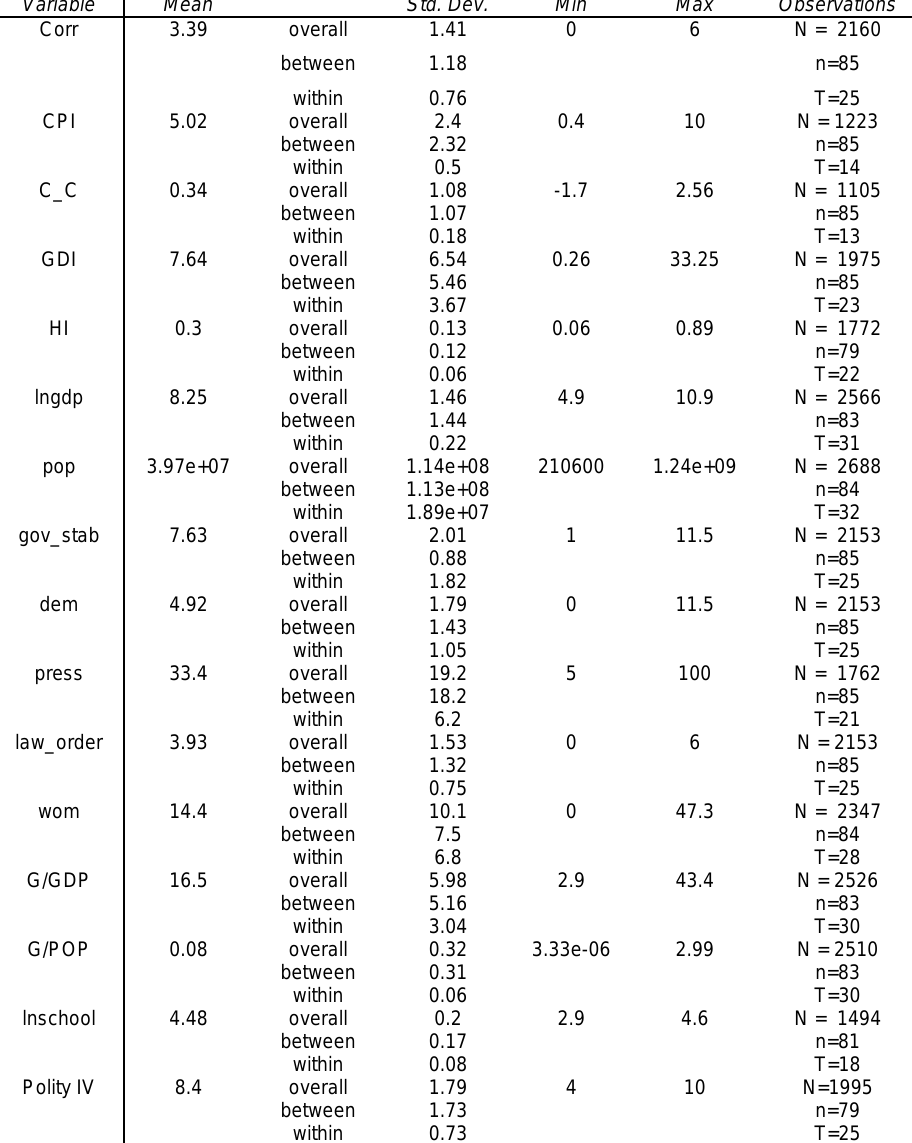
Table A2: Descriptive statistics of variables